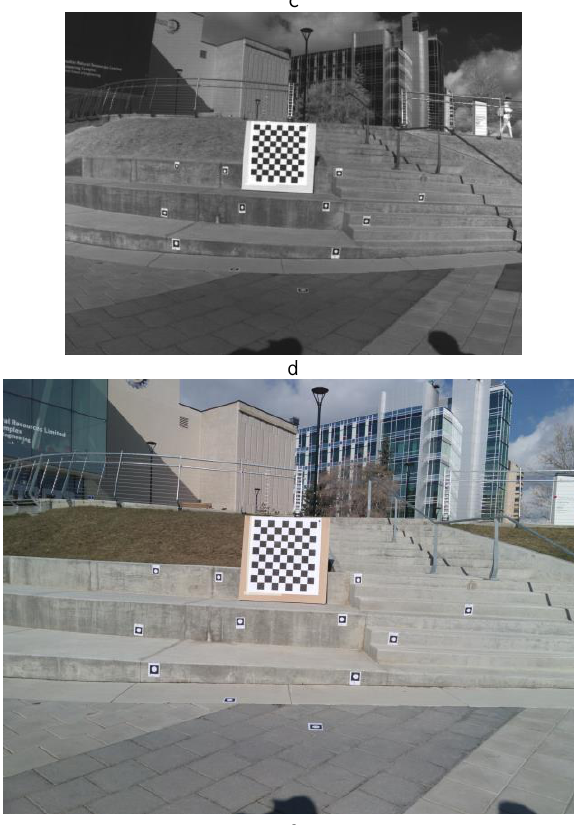
Figure 2. raw images captured by the camera; a) Red band; b) Green band; c) Red-edge band; d) Near-infrared band; e) RGB